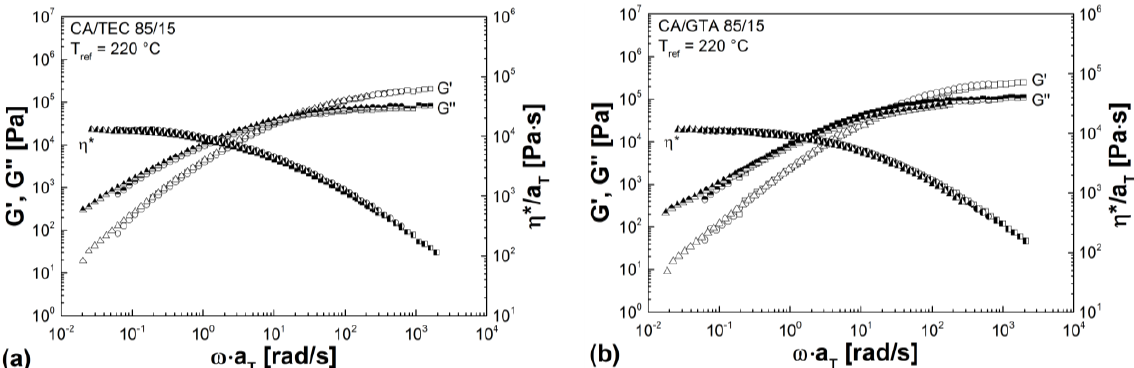
Figure 8. ( a ) Temperature-dependent master curves for non-crosslinked CA/TEC (85/15) as a function of radial frequency. ( b ) Temperature-dependent master curves for non-crosslinked CA/GTA (85/15) as function of radial